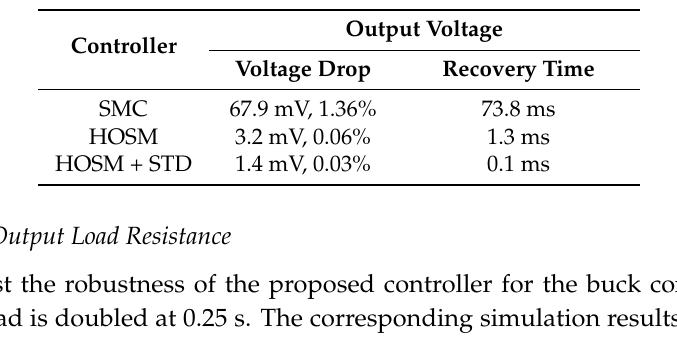
Table 5. Output load disturbance analysis results. Controller